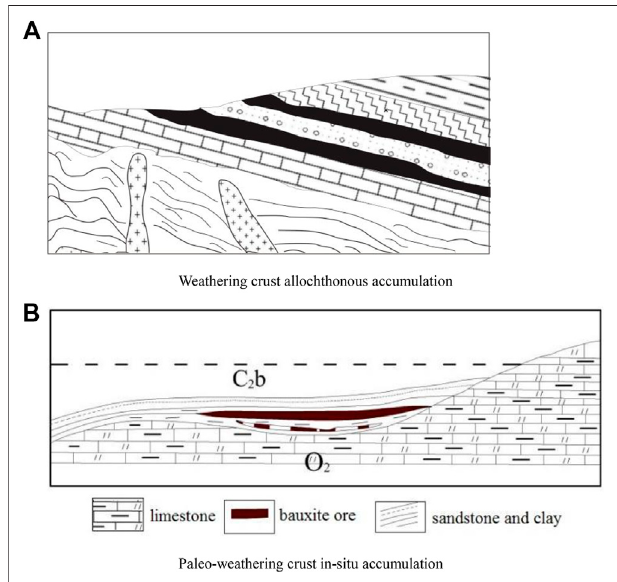
FIGURE 3 | Metallogenic model of the weathered crust sedimentary bauxite. (A) Weathering crust allochthonous accumulation. (B) Paleo- weathering crust in-situ accumulation.